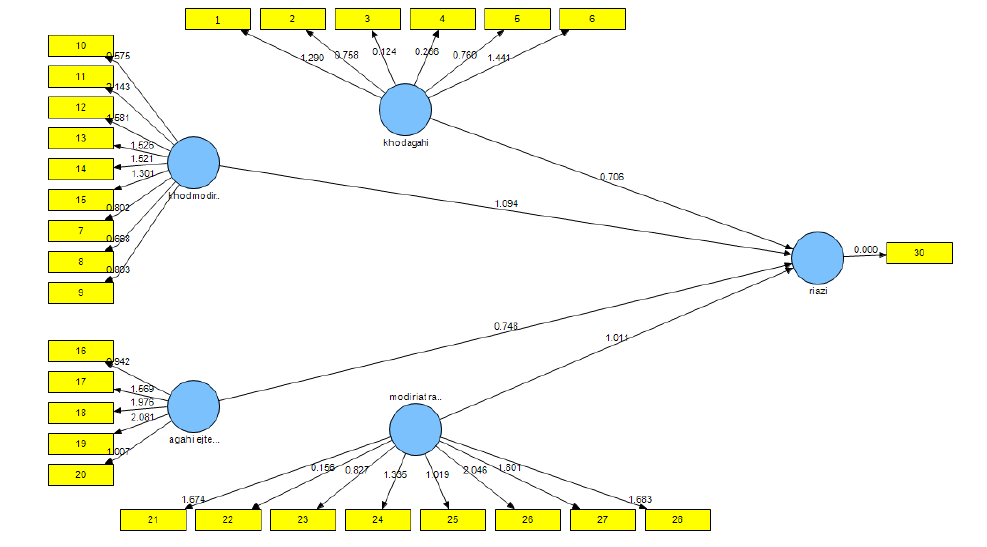
Fig. 1. Significance coefficient t.